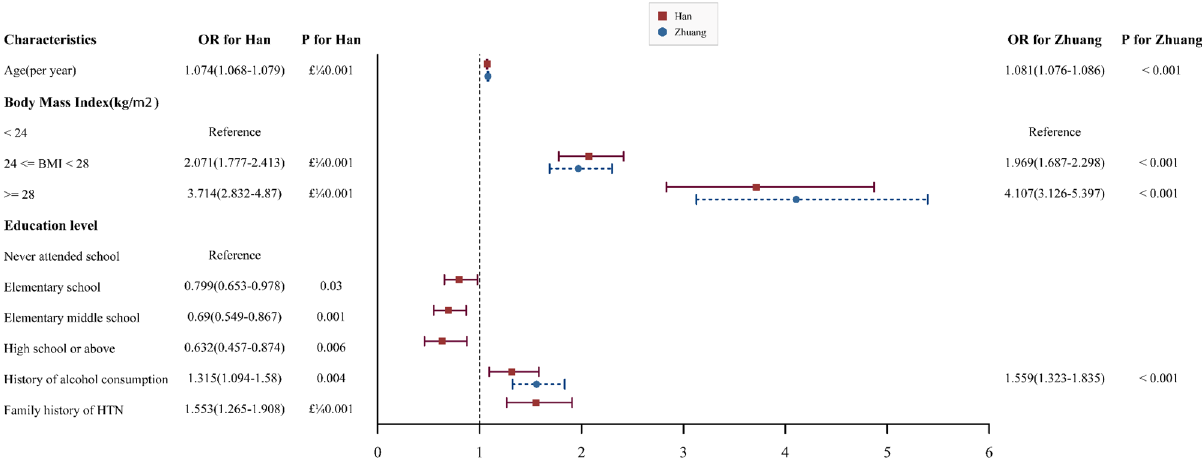
Figure 3. Risk factors of HTN for the Han and Zhuang